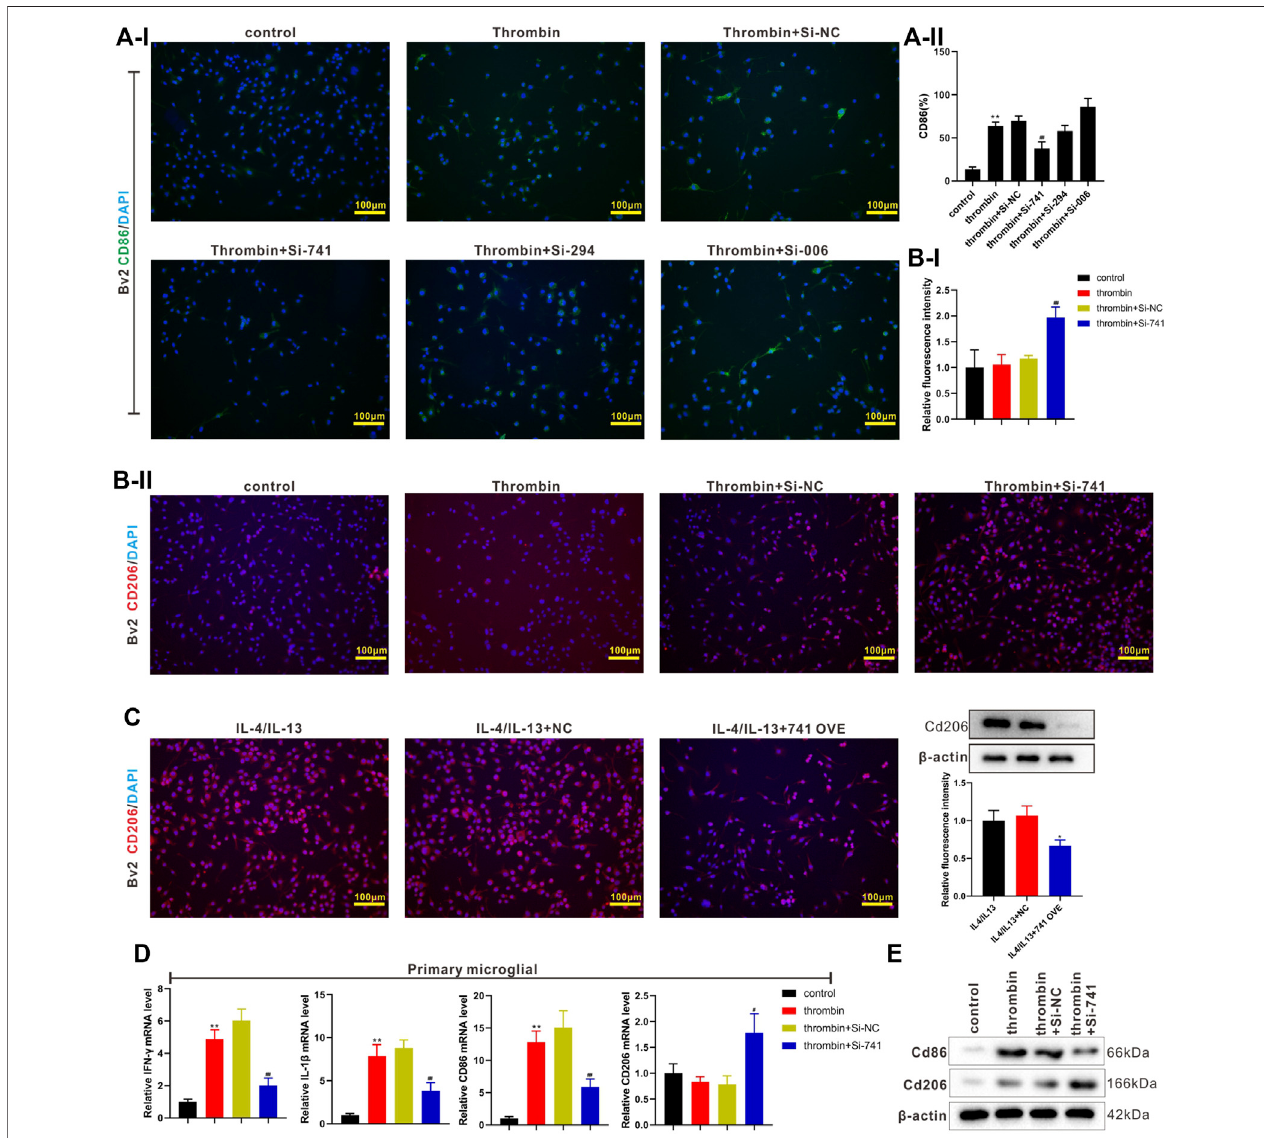
FIGURE3| EffectofTCONS_00145741ontheactivationofM1andM2microgliaunderthrombintreatment. (A) si-741,si-294,orsi-006wastransfectedintoBV2 cellsand thenthecellsweretreatedwith20U/mlthrombinfor24 h.Animmuno fl